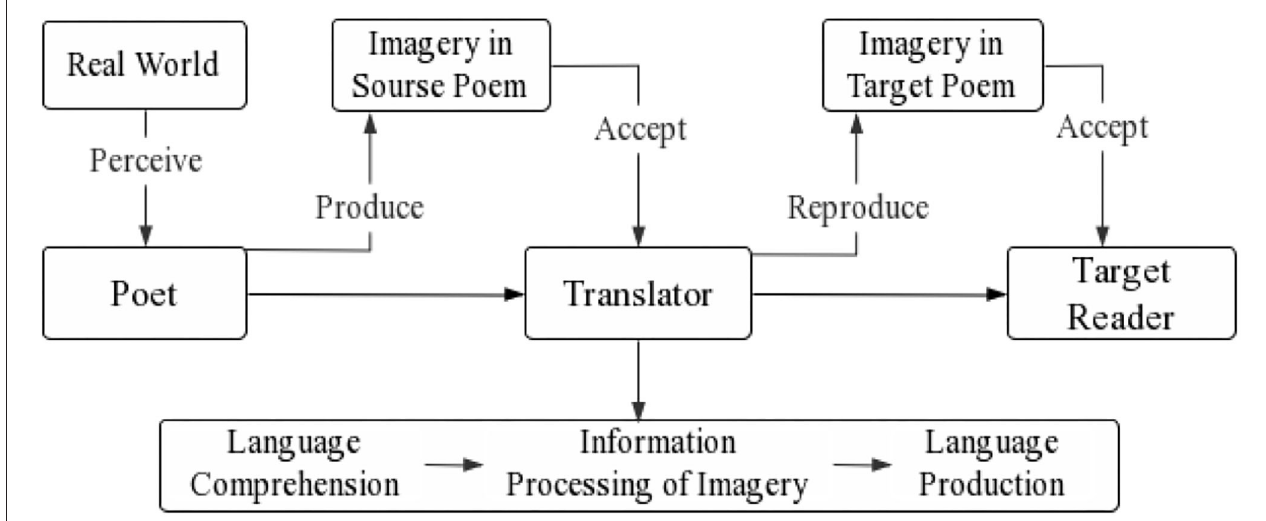
FIGURE 1 | The cognitive process of poetry imagery